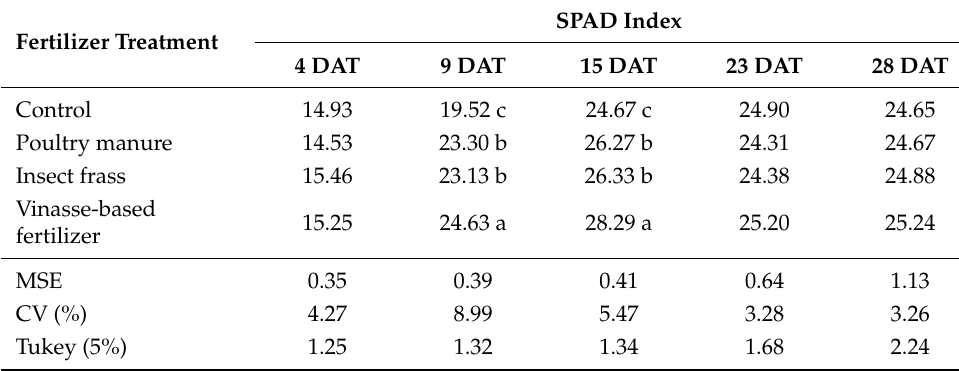
Table 1. Effect of fertilizer treatments on chlorophyll concentration expressed as SPAD index of lettuce leaves.